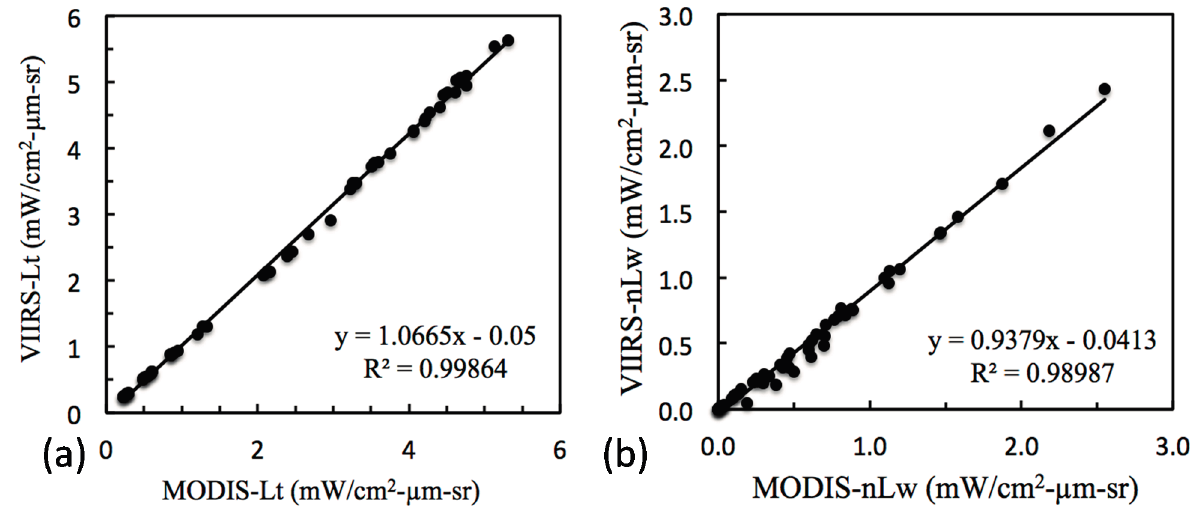
Figure 4. ( a ) Scatter plot of VIIRS versus MODIS Lt measurements for the eight locations marked in Figure 1, and ( b ) Scatter plot of VIIRS versus MODIS APS-derived nLw estimates for the eight locations with the best-fit least-squares regression